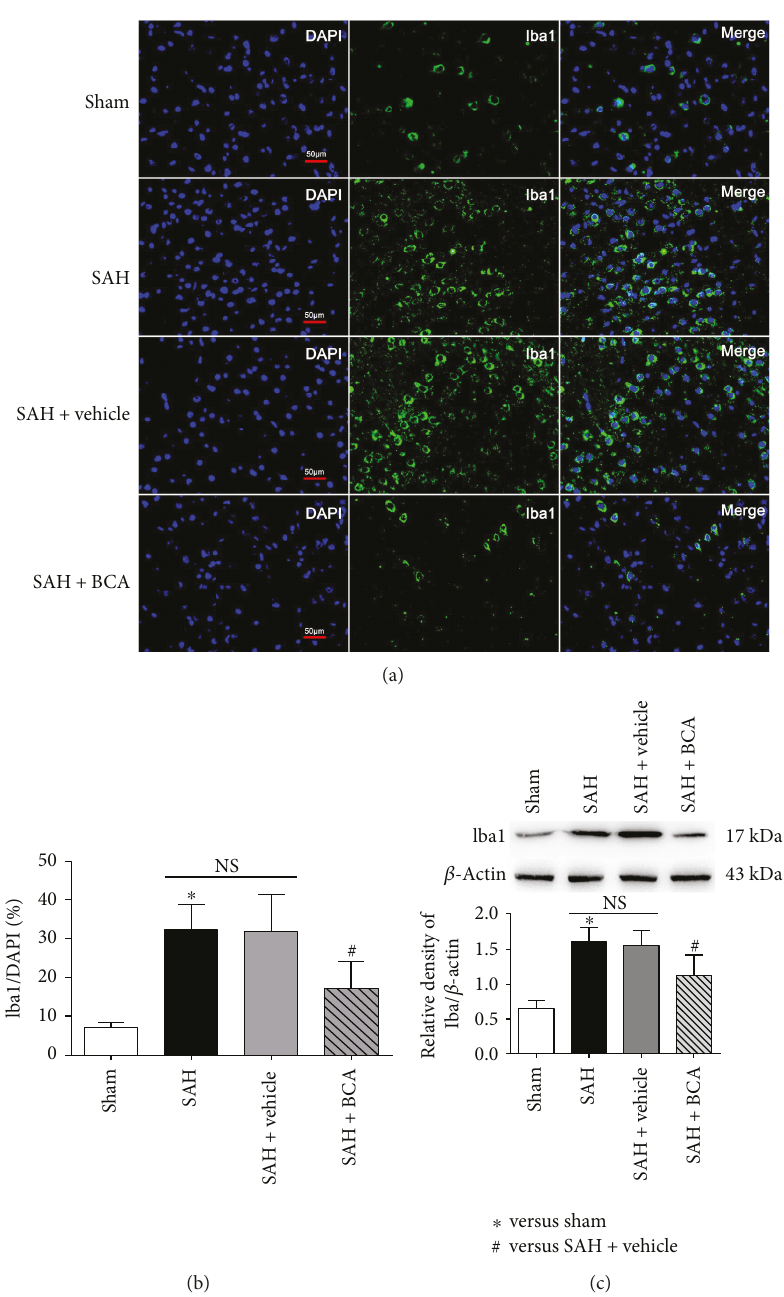
Figure 4: The e ff ects of BCA on microglial activation at 24h post SAH. (a, b) Immuno fl uorescence staining: Iba1=green, DAPI=blue, scale bars = 50 μ m . (c) Western blot analysis.( n = 6 , each group; ∗ P < 0 05 , versus sham; # P < 0 05 versus SAH+ vehicle; NS P > 0 05